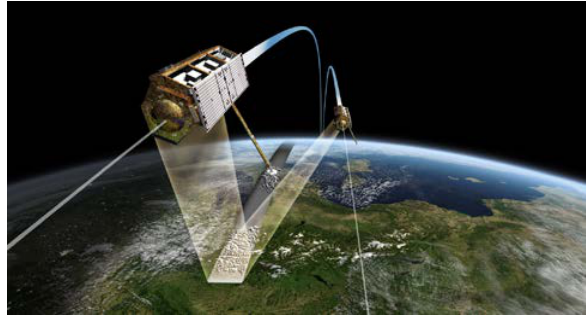
Figure 1: TSX and TDX satellites flying in close formation